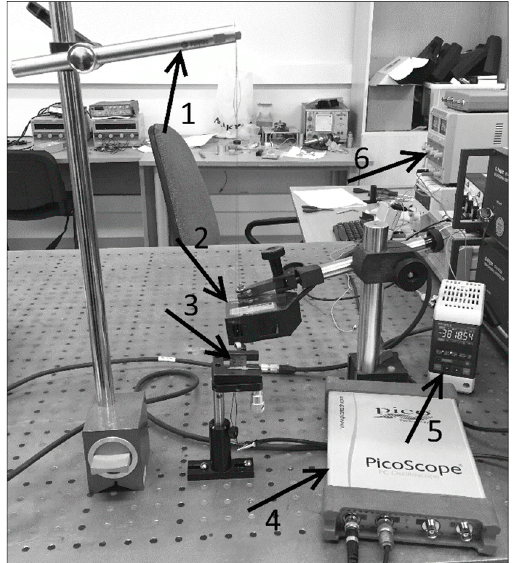
Figure 2. Experimental setup consisting of: ( 1 ) a mathematical pendulum; ( 2 ) a LK-G82 sensor head; ( 3 ) an investigated element; ( 4 ) PicoScope oscilloscope; ( 5 ) LK-G3001PV control block; and ( 6 ) a power supply block.